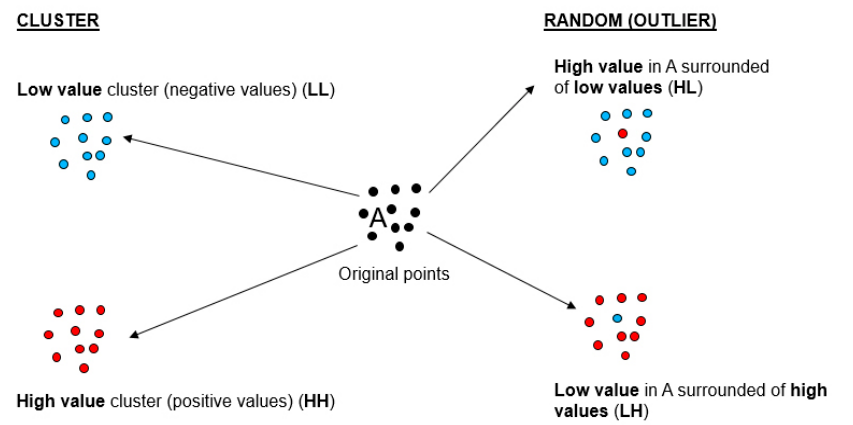
Figure 6. Cluster classification scheme.